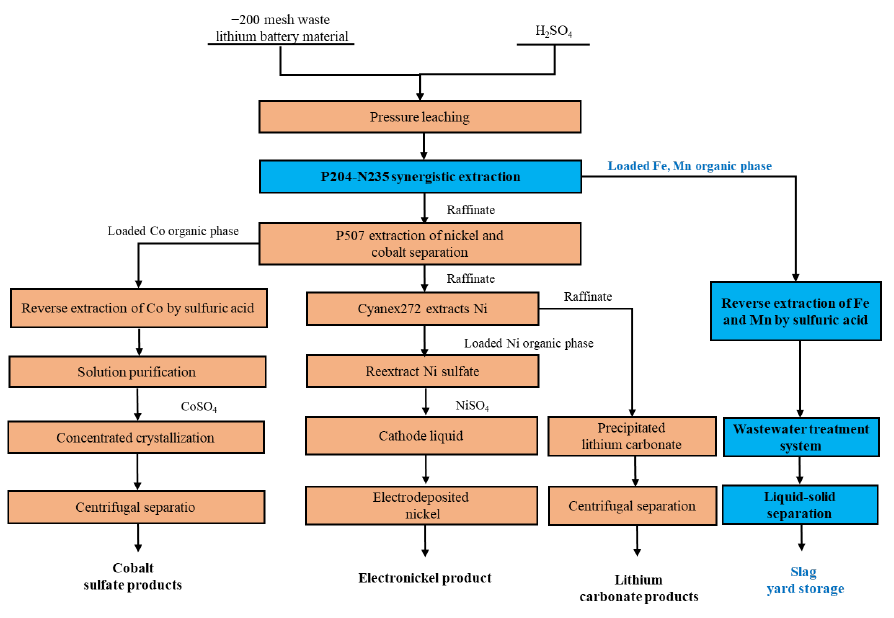
Figure 5. Process flow